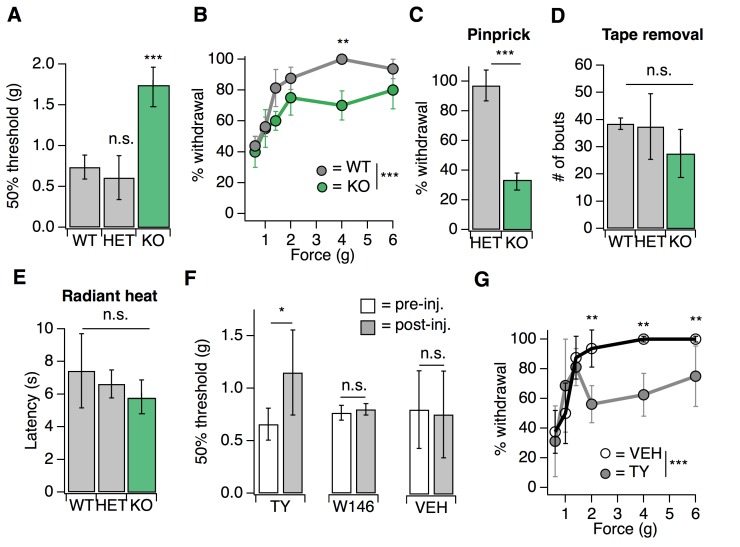
S1PR3 mediates acute mechanical pain.(A) von Frey 50% withdrawal threshold measurements for S1pr3+/+ (WT, N = 8), S1pr3+/- (HET, N = 7) and S1pr3-/- (KO, N = 12) mice. p<0.0001 (one-way ANOVA). Tukey-Kramer post hoc comparisons for KO and HET to WT indicated on graph. (B) von Frey force-response graph for WT (N = 8) versus KO (N = 12) animals; pgenotype <0.0001 (two-way ANOVA). Tukey HSD comparisons between genotypes are indicated for given forces. (C) % withdrawal to pinprick stimulation of hindpaw for HET versus KO animals; p<0.0001 (unpaired t-test; N = 5–7 mice per group). (D) Number of attempted removal bouts in tape assay for WT (N = 2), HET (N = 2), and KO (N = 5) mice; p=0.172 (one-way ANOVA). (E) Baseline radiant heat measurements for WT (N = 8), HET (N = 3), and KO (N = 5) mice; p=0.444 (one-way ANOVA). (F) von Frey 50% withdrawal threshold measurements for mice pre- and post-injection of 500 µM TY 52156 (N = 10), 10 µM W146 (N = 6), or 1% DMSO-PBS vehicle (N = 17); p=0.016, 0.650 (two-tailed paired t-test comparing vehicle- vs. drug-injected paw). (G) von Frey force-response graph for mice injected with either 1% DMSO-PBS (N = 4) or 500 µM TY 52156 (N = 4); ptreatment <0.0001 (two-way ANOVA). Tukey HSD comparisons were made between treatment groups and significant differences at a given force are indicated on graph. Error bars represent mean ± SD.10.7554/eLife.33285.004Figure 1—source data 1.S1PR3 mediates acute mechanical pain.Related to Figure 1.